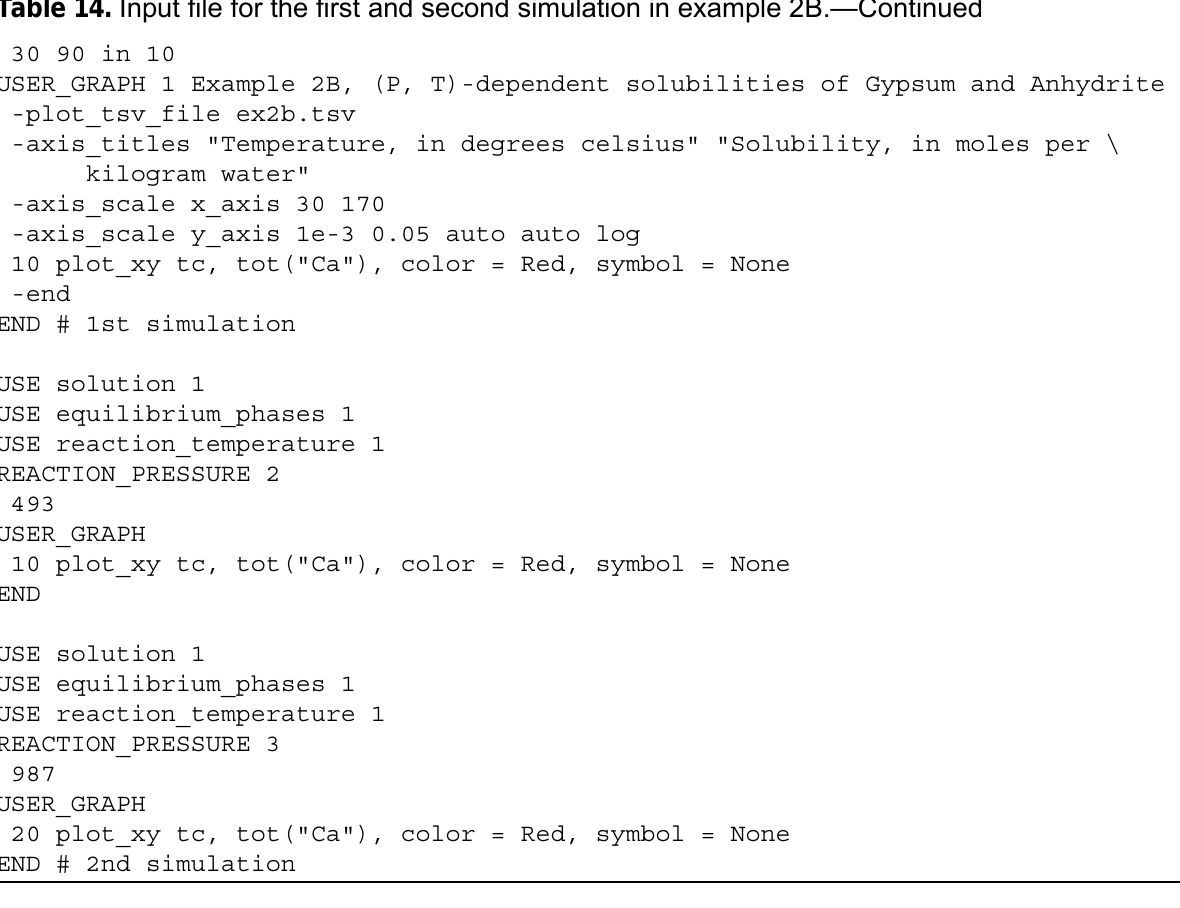
Table 14. Input file for the first and second simulation in example